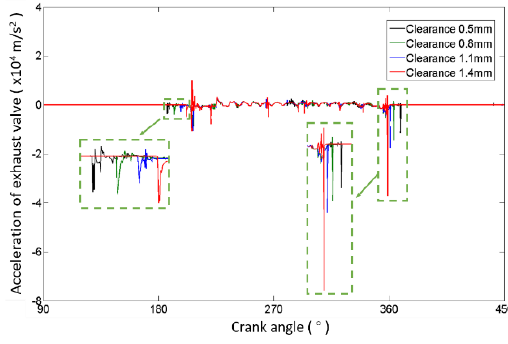
Figure 7. Valve acceleration of different clearances.